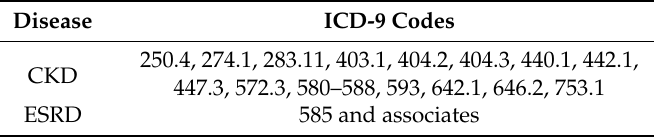
Table A1. ICD-9 codes for CKD and